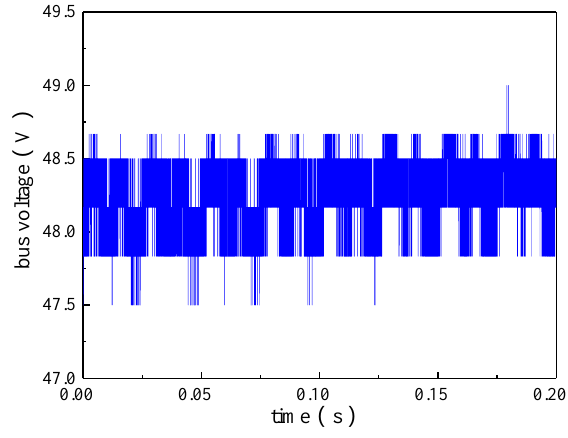
Figure 15. Bus voltage waveforms during steady state generating test.